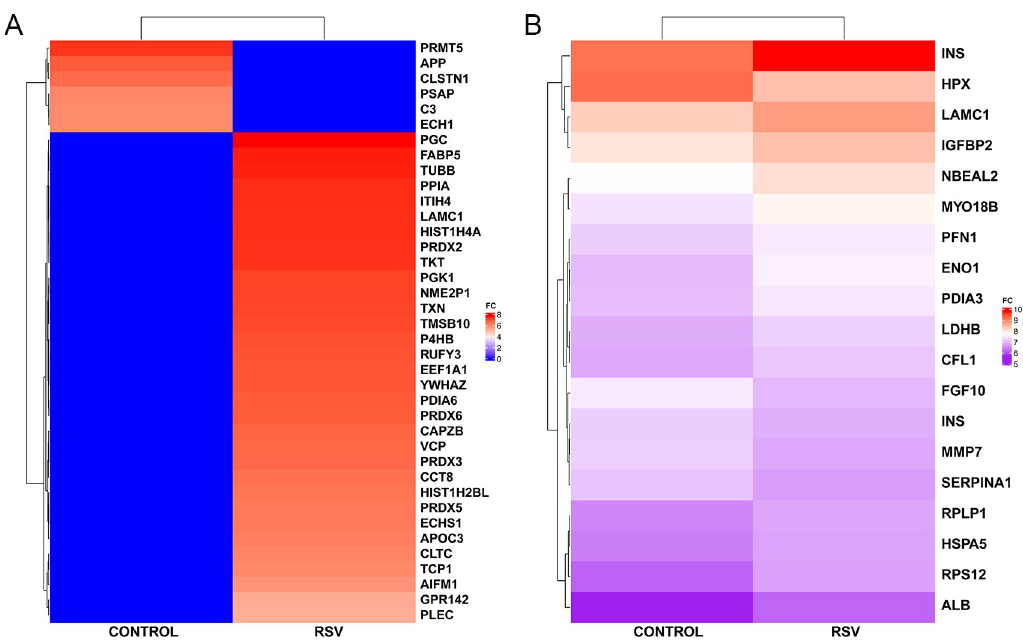
Fig 5. Proteomic analysis of RSV-infected organoids. Heatmaps of dysregulated proteins exhibiting � 2-fold change in RSV- infected vs. non-infected control organoids, using discrete color to represent proteins abundance after log10-transform. (A) Proteins are uniquely identified in either control or RSV groups. Blue label means no signals were being captured for the corresponding proteins. (B) Proteins were identified in both control and RSV groups but with at least two-fold changes between